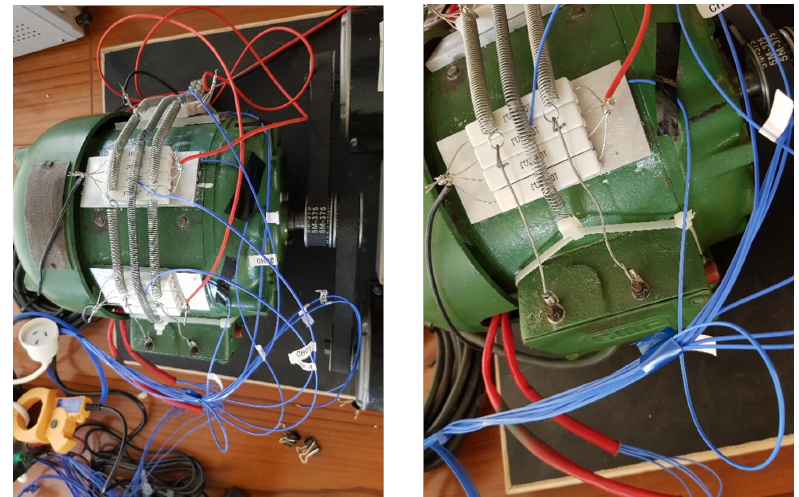
Figure 7. Resistive heating of the test motor.